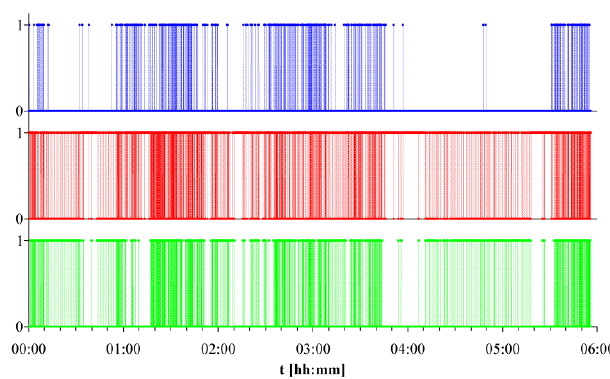
Fig. 10. Three-colour led colour led control signals, (the indication of the type of the fuel-air mixture) Only one of the three signals is high at a given time.